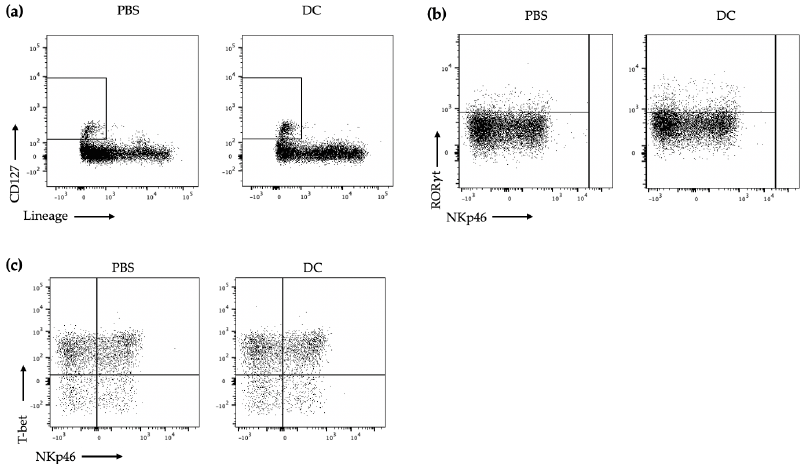
Figure A3. Representative dot plots of the flow cytometry staining controls for flow cytometry gating. Control mice that received phosphate-buffered saline (PBS) and mice that received DC-based vaccinations were examined for populations of ( a ) CD127 + and lineage − , ( b ) ROR γ t + , and ( c ) T-bet + NKp46 +/ −